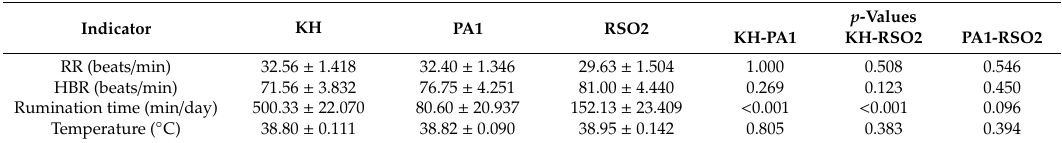
Table 2. The heartbeat rate (HBR), respiratory rate (RR), rumination time, and temperature for each group of cows. Indicator KH PA1